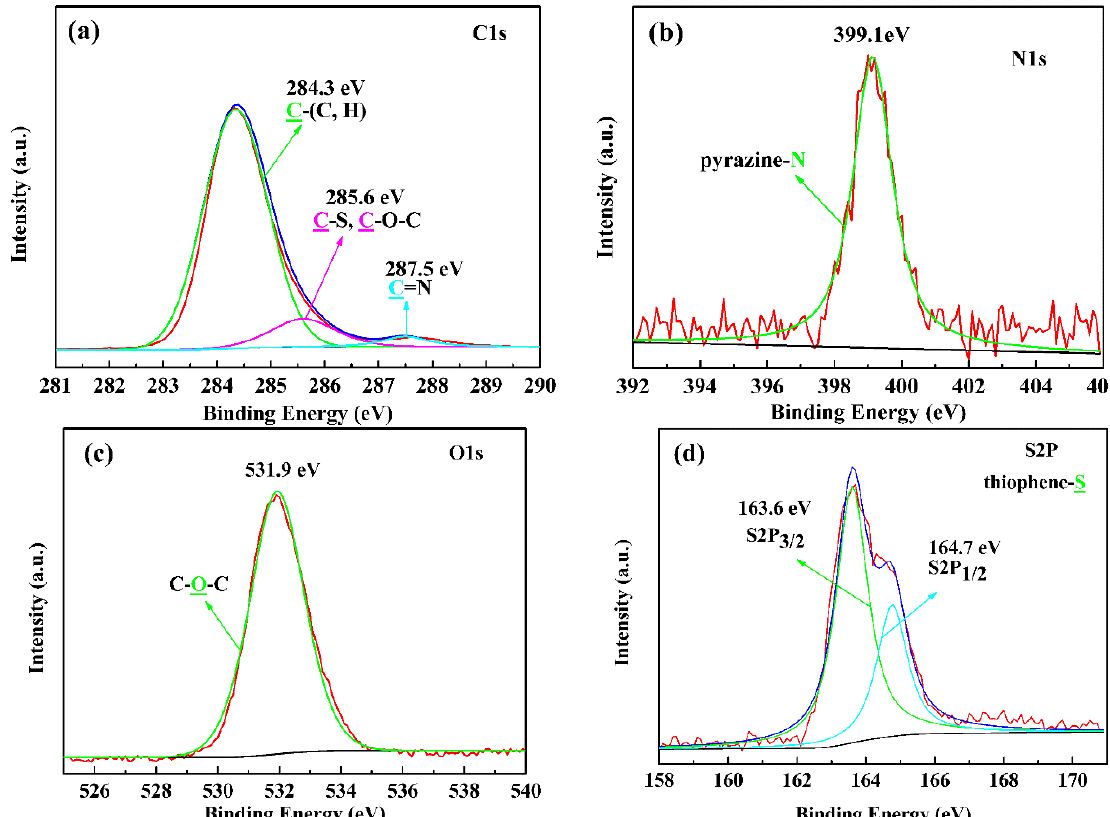
Figure 3. XPS spectra of polymer PBPE-1: ( a ) C1s, ( b ) N1s, ( c ) O1s and ( d ) S2p. The colored arrows point to the corresponding elemental valence states and their peaks.